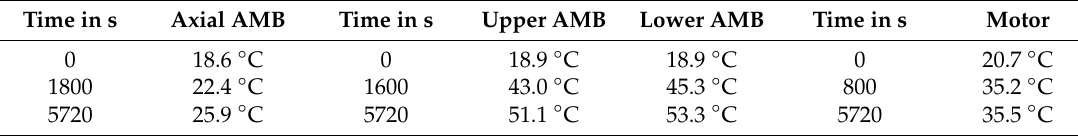
Table A2. Measured stator temperature during cycling with a bias current of 5.67